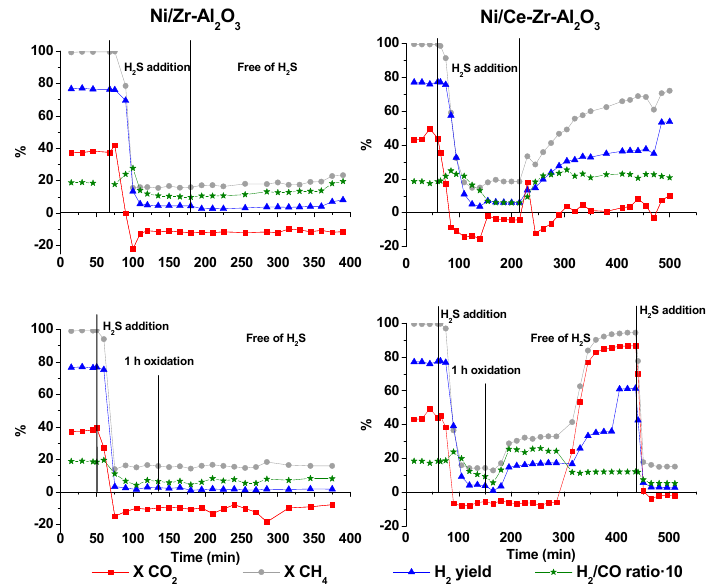
Figure 1. Katalco 57-5 Ni-Al 2 O 3 catalyst activity results. Top : self-regeneration. Bottom : Regeneration by oxidation. Reaction conditions: 210.0 mL/min CH 4 , 140.0 mL/min CO 2 , 197.7 mL/min N 2 , 52.5 mL/min O 2 , 0.169 mL/min H 2 O at 800 °C and atmospheric pressure. WHSV of 161.5 g gas ·g cat − 1 ·h − 1 (0.340 g of catalyst).